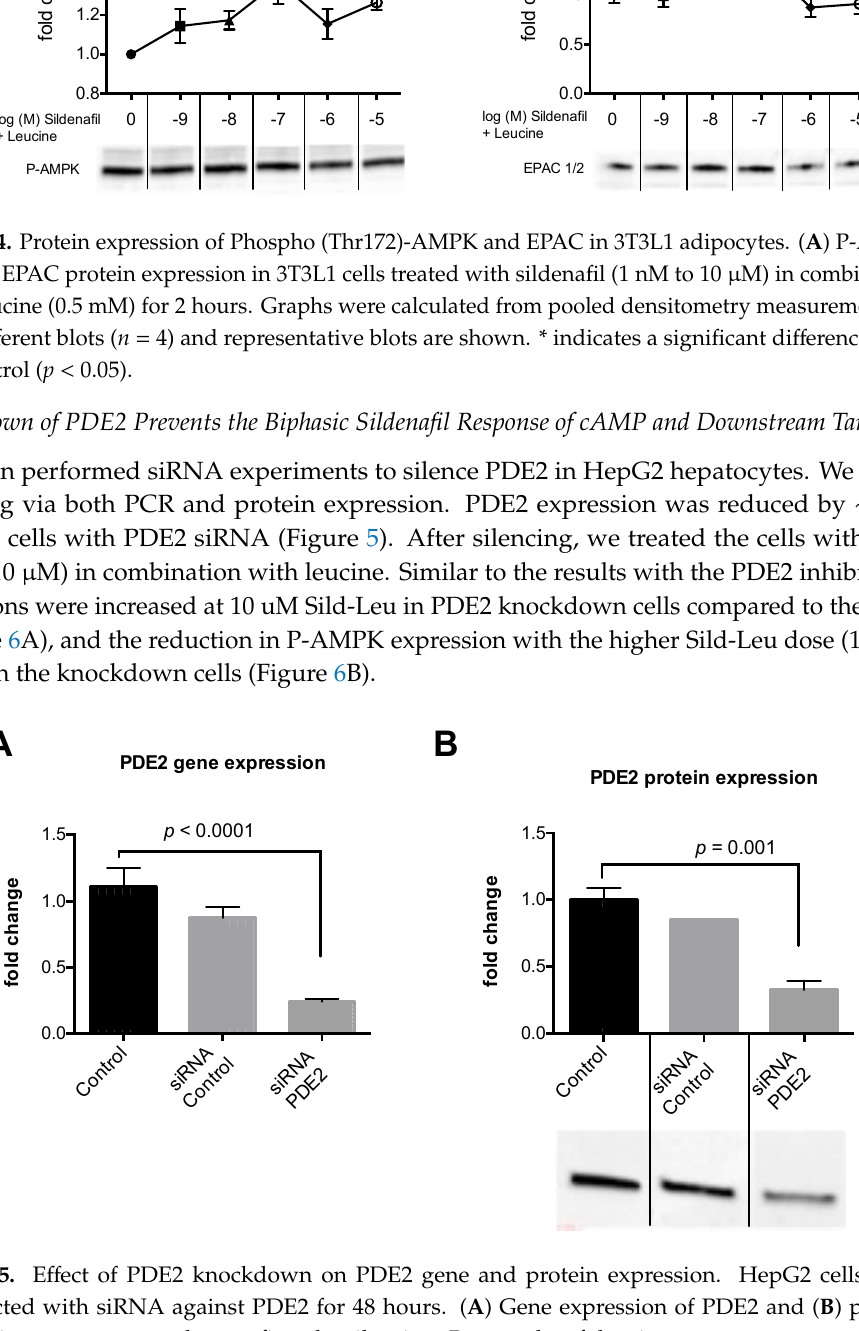
the curves ( p < 0.03).